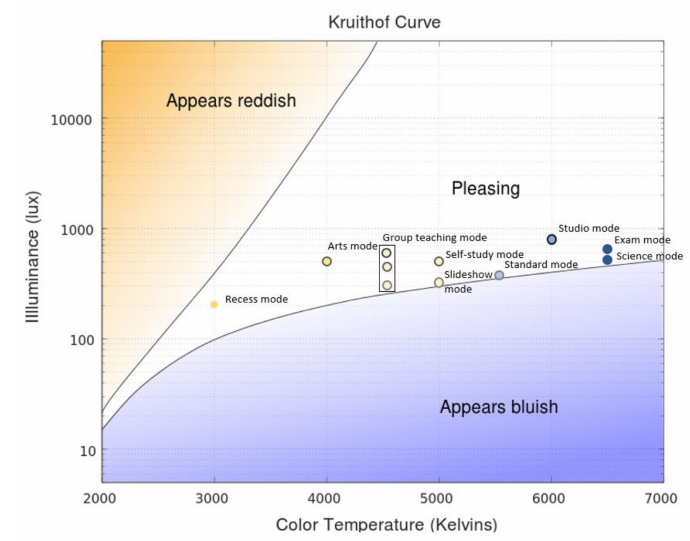
Figure 16. Proposed lighting modes within pleasing zone of Kruithof Curve.